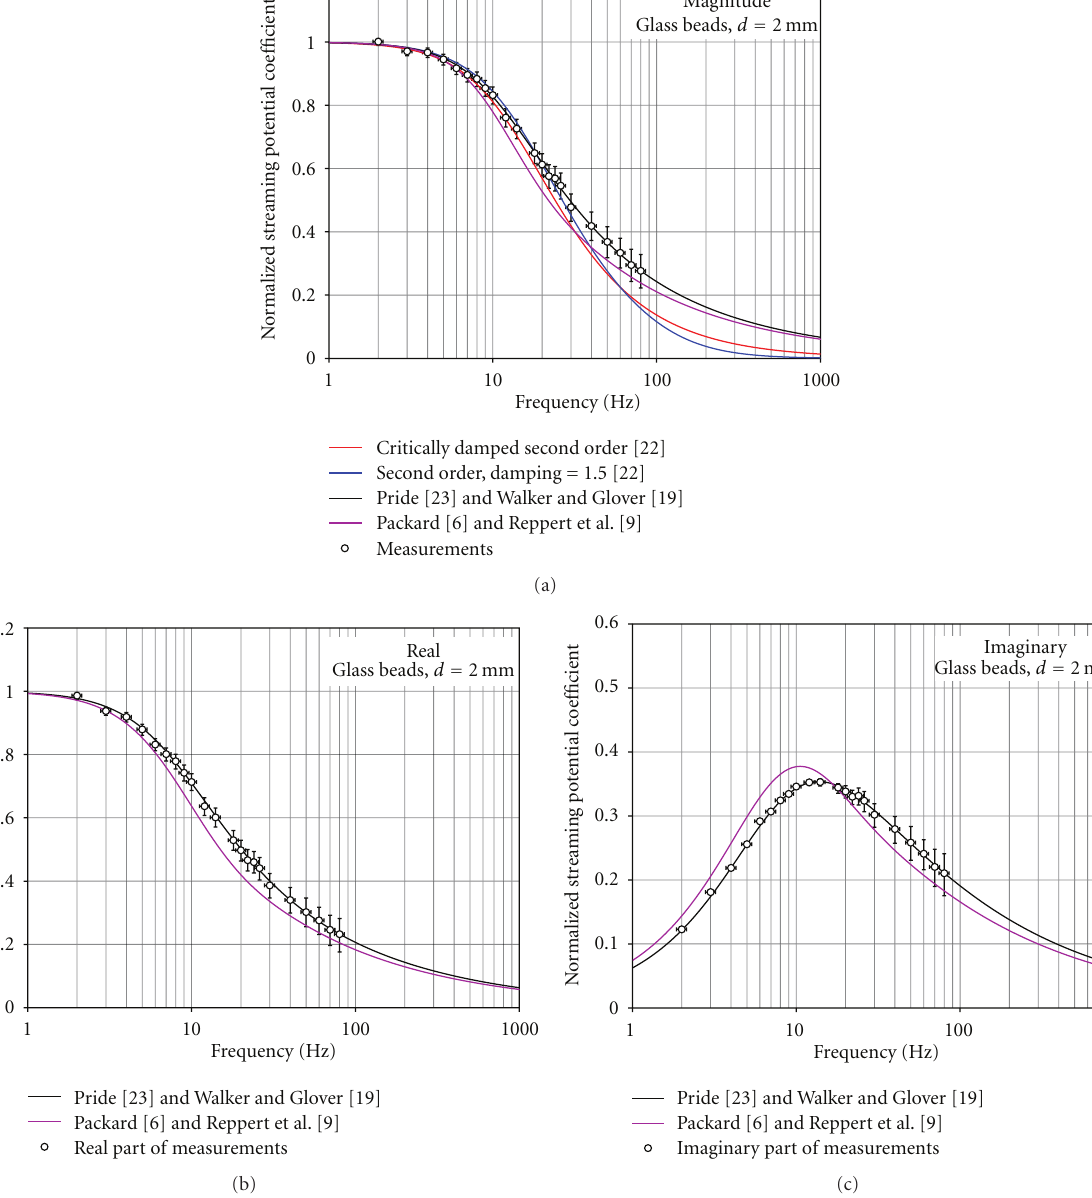
Figure 6: The calculated streaming potential coupling coe ffi cient (normalised to the value at 2Hz, which was 1.80 V/MPa) as a function of frequency for a pack of nominally 2mm diameter glass beads saturated with 10 − 3 mol/L NaCl solution at 24 ◦ C ( φ = 0 . 382, κ DC = 27 . 2 × 10 − 10 m 2 ). (a) Magnitude with six models shown fitting the data [6, 9, 19, 22, 23], (b) real component for models [6, 9, 19, 23], and (c) imaginary component for models [6, 9, 19,